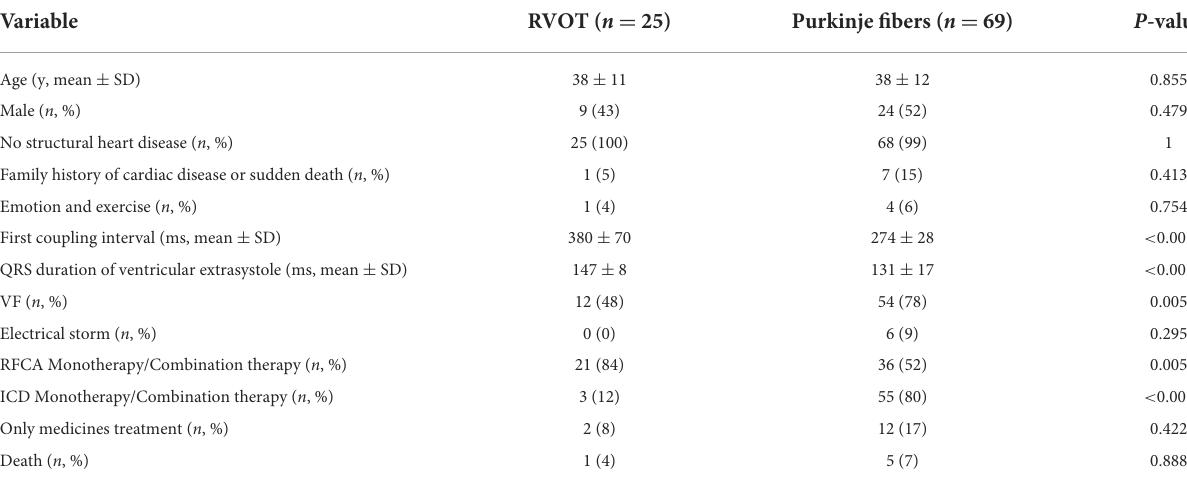
TABLE 3 Clinical characteristics of the different ventricular extrasystole’s